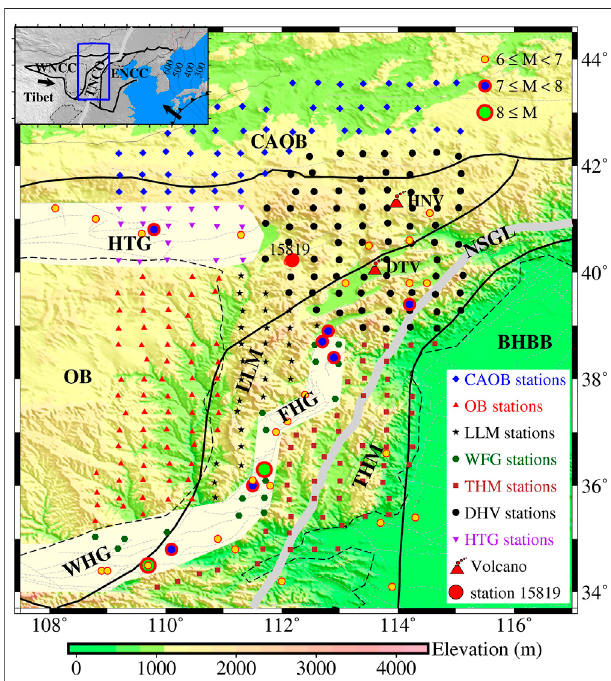
FIGURE 1 | Tectonic setting map showing the seismic stations used in this study. Stations located in different blocks are indicated with different symbols. The red solid circle represents station 15,819 as an example of the H- κ analysisand crustal anisotropy in Figures2 , 3 . Thecolor circles with red solid line are the large historic earthquakes (M ≥ 6, Liu and Wang, 2012). The thick gray line denotes the North-South Gravity Line (NSGL). Lightyellow regions are Hetao, Weihe and Fenhe grabens. DTV, the Datong Volcano; HNV, the Hannuoba Volcano; CAOB, the Central Asia Orogenic Belt; OB, the OrdosBlock;LLM,theLüliangMountain; THM,theTaihangMountain;BHBB, theBohaiBayBasin;HTG,theHetaoGraben;WHG,theWeiheGraben;FHG, the Fenhe Graben. Inset shows the location of the Trans-North China Orogen with the blue rectangular. The black thick arrowhead indicates the absolute plate motion (APM) direction from GSRM v2.1 model (Kreemer et al., 2014).